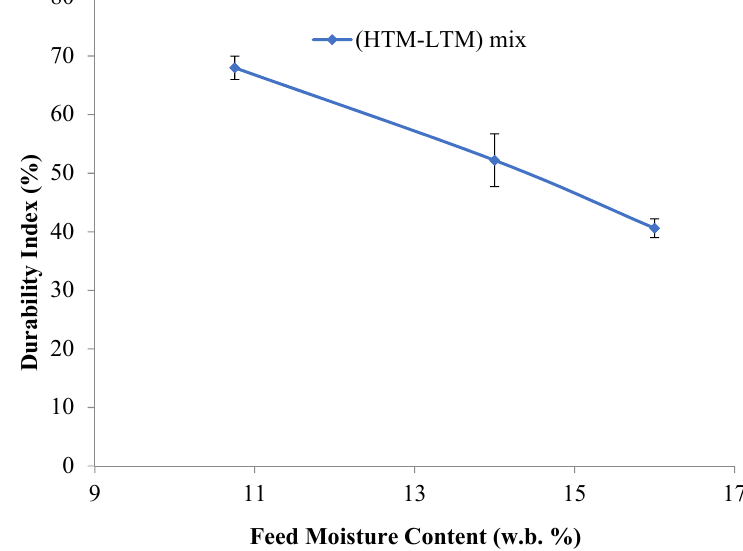
Figure 15. Durability versus feed moisture content for the HTM-LTM mixtures.